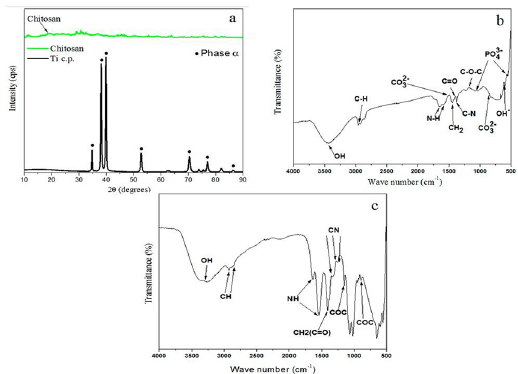
Figure 6. (a) X-ray diffraction (XRD) at condition C1 (cp- Ti+HA+AgNO +CH) and chitosan film. (b) Infrared spectrum at 3 +CH). (c) Infrared spectrum of condition C1 (cp-Ti+HA+AgNO 3 the chitosan